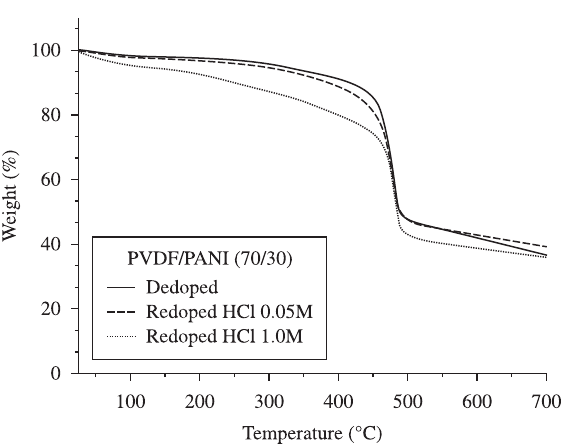
Figure 4. Thermogravimetric analysis of PVDF/PANI blends (30 wt. (%) PANI) dedoped and redoped with HCl 0,05 M and 1,0 M.